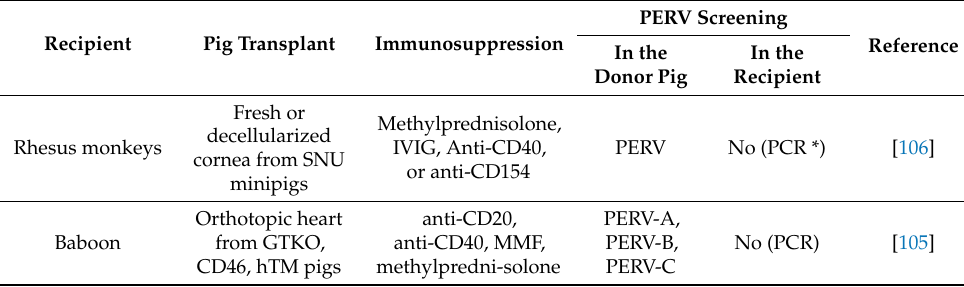
Table 2. Recent preclinical xenotransplantations with reported PERV